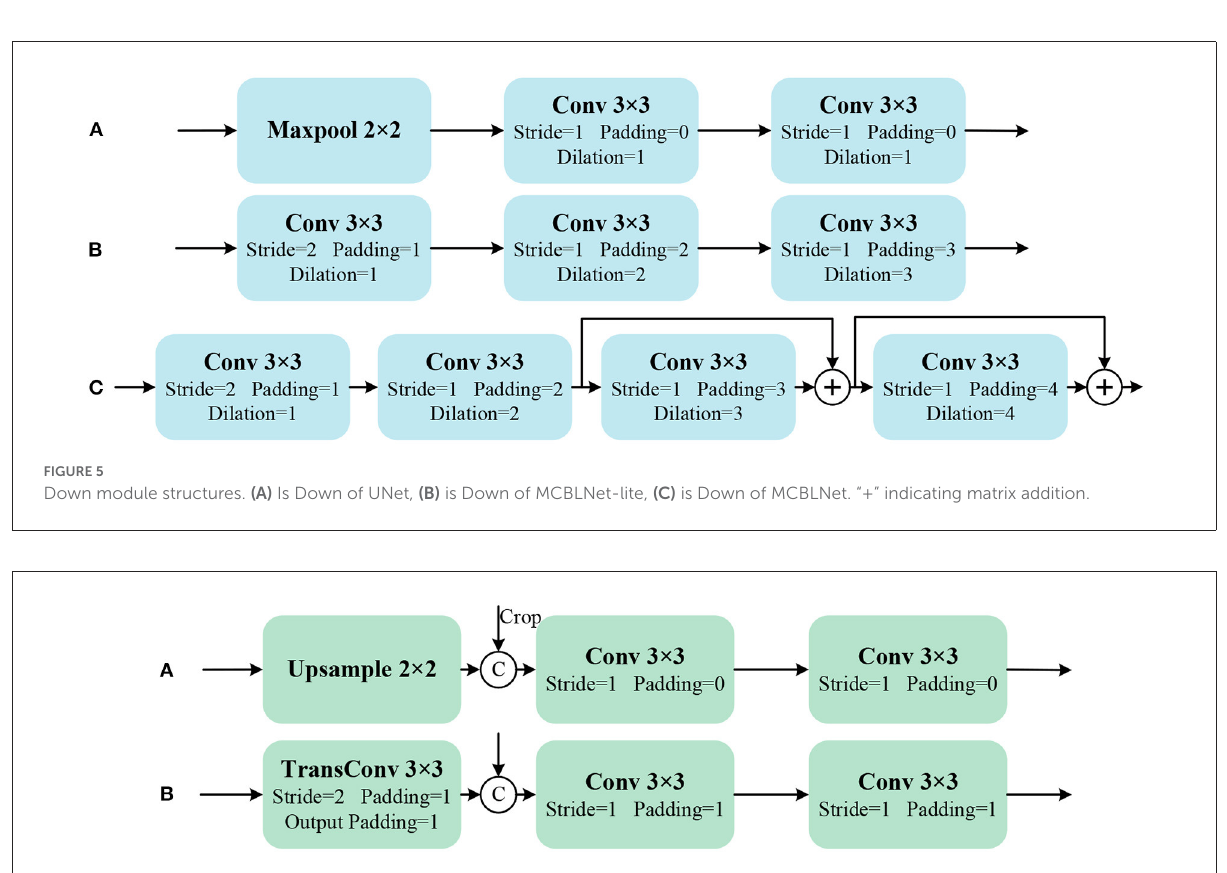
FIGURE6 Up module structures. (A) Is Up of UNet, (B) Is Up of MCBLNet. “C” representing